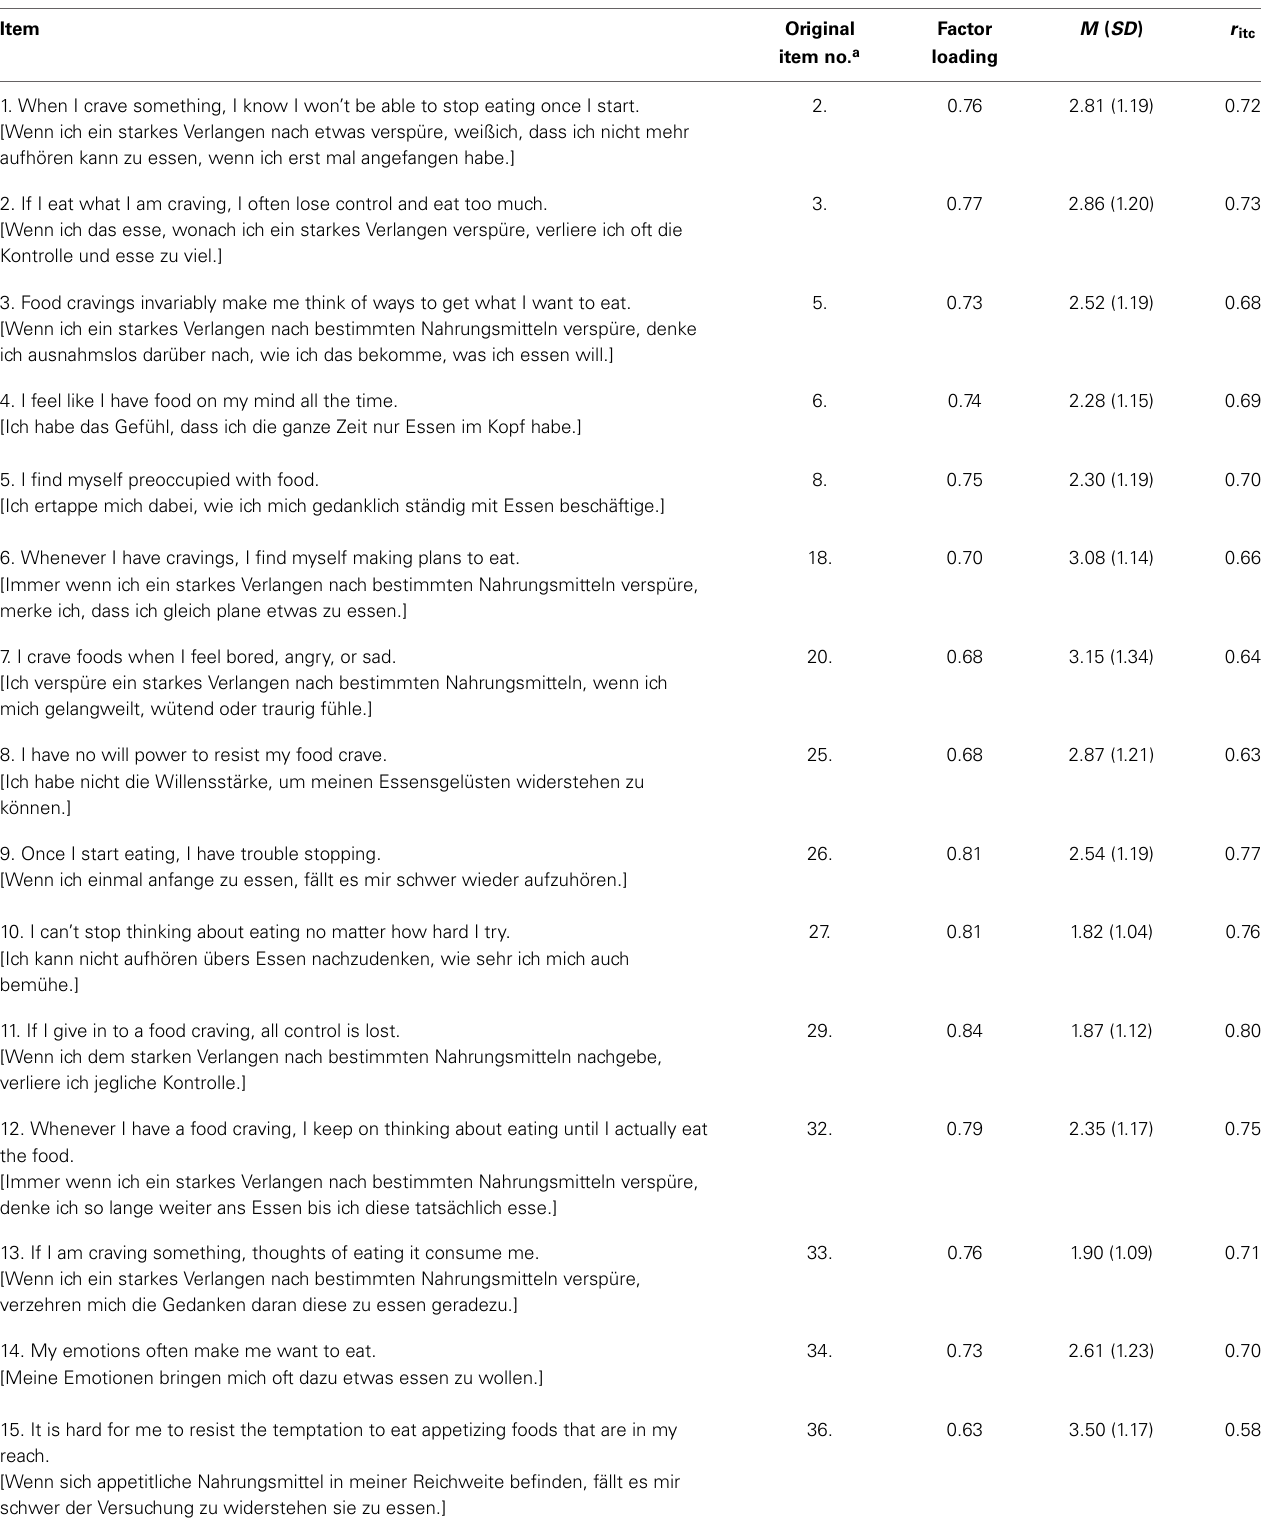
Table 1 | Factor loadings and item statistics of the Food Cravings Questionnaire—Trait—reduced in study 1.